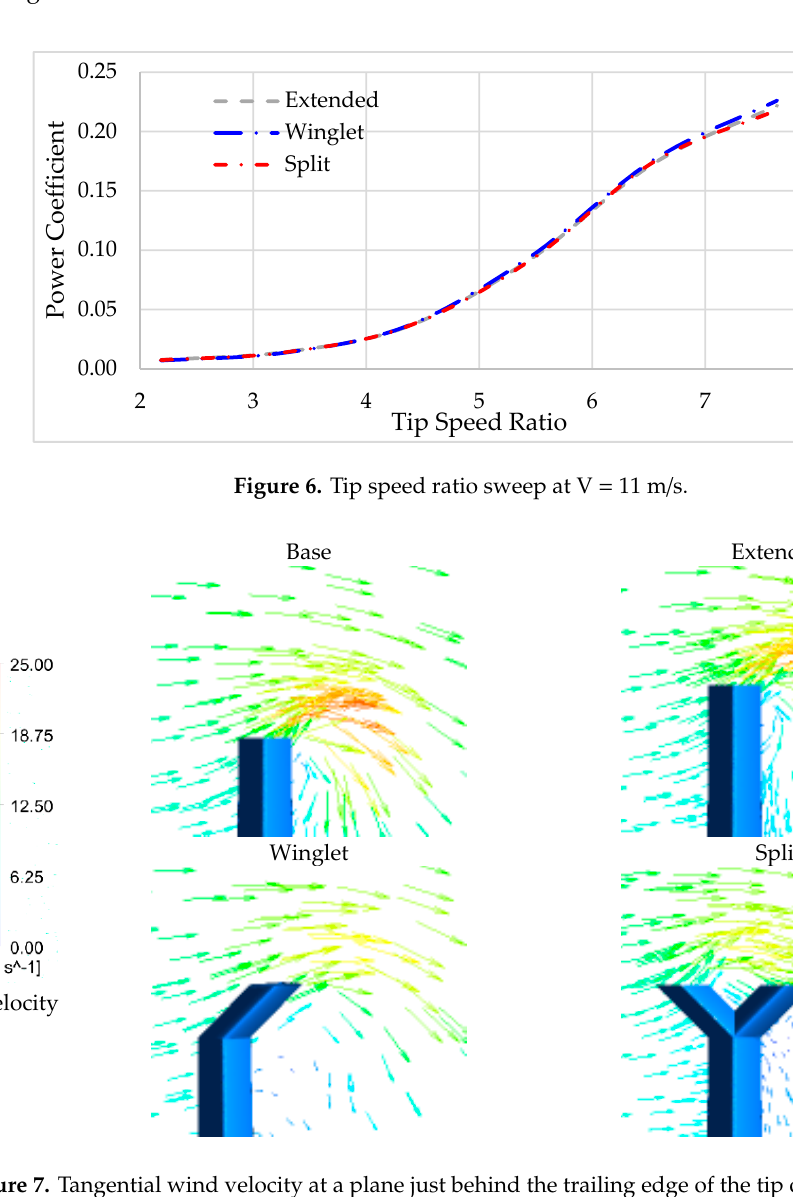
Figure 6. Tip speed ratio sweep at V = 11 m/s.